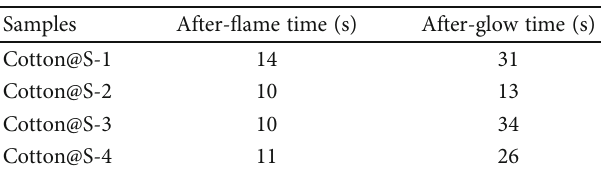
Figure 6: Thermal performance analysis of composite fi lms: (a) TG and (b) DTG. Table 2: Vertical combustibility data of cotton fabric coated with WPU composite fi lms.